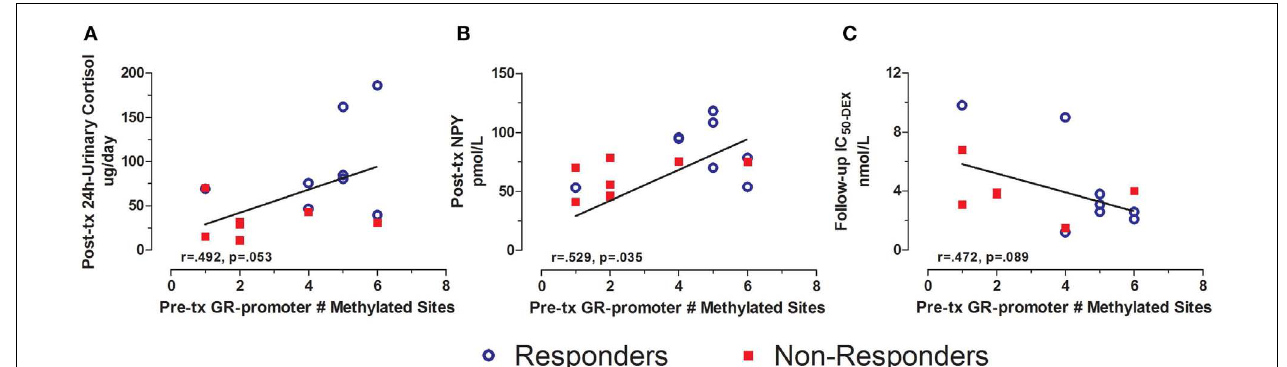
n = 6 for IC 50-DEX ) by red squares.The higher number of GR exon 1F promoter methylated sites at Pre-treatment corresponded to higher adjusted 24h-urinary cortisol and NPY at Post-treatment and lower IC 50-DEX at follow-up (trend). About 24h-urinary cortisol was adjusted for BMI and gender using linear regression and adding unstandardized residuals to the initial raw levels. Correlation coefficients are denoted in the different panels. Statistical significance was set at p < 0.05.